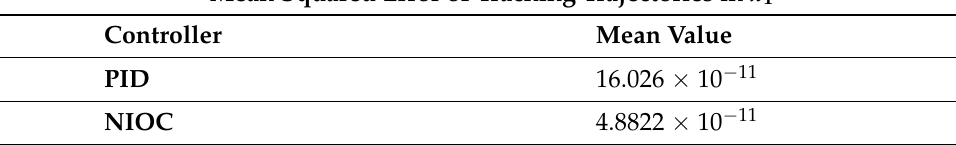
Table 3. Mean squared error in x 2